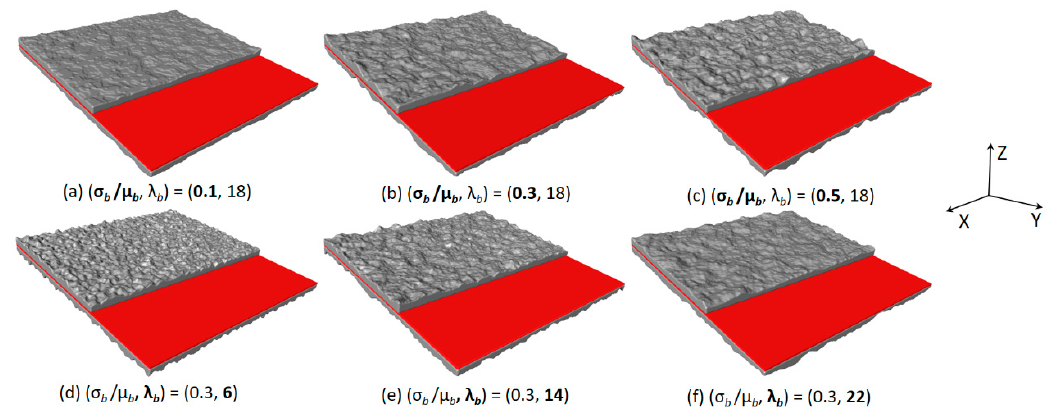
Figure 10. With fixed σ T2 = 0 and λ T = ∞ , ( a–c ) demonstrate the influence of fracture apertures with various σ b / μ b but the same λ b ; and ( d–f ) show the influence of fracture apertures with various λ b but the same σ b / μ b . The modelling trend surfaces are in red.